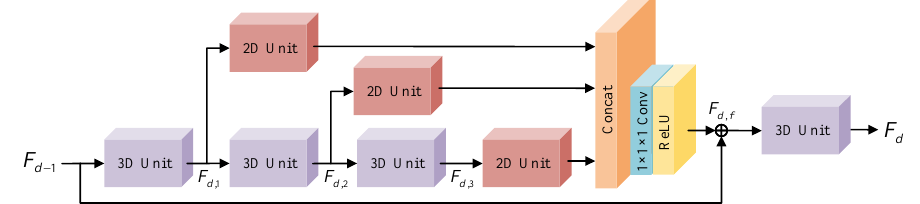
Figure 4. Architecture of the d -th mixed convolutional module (MCM). The module mainly contains four 3D units, three 2D units, and local feature fusion. The feature maps from F d − 1 are first fed into the first 3D unit. After two 3D units, the output feature maps of each 3D unit is reshaped. These feature maps are fed into 2D unit, respectively. Then, the feature output from 2D units of different depths are concatenated together. More effective features are attached to 3D unit after local residual learning. Finally, the output of the module F d is